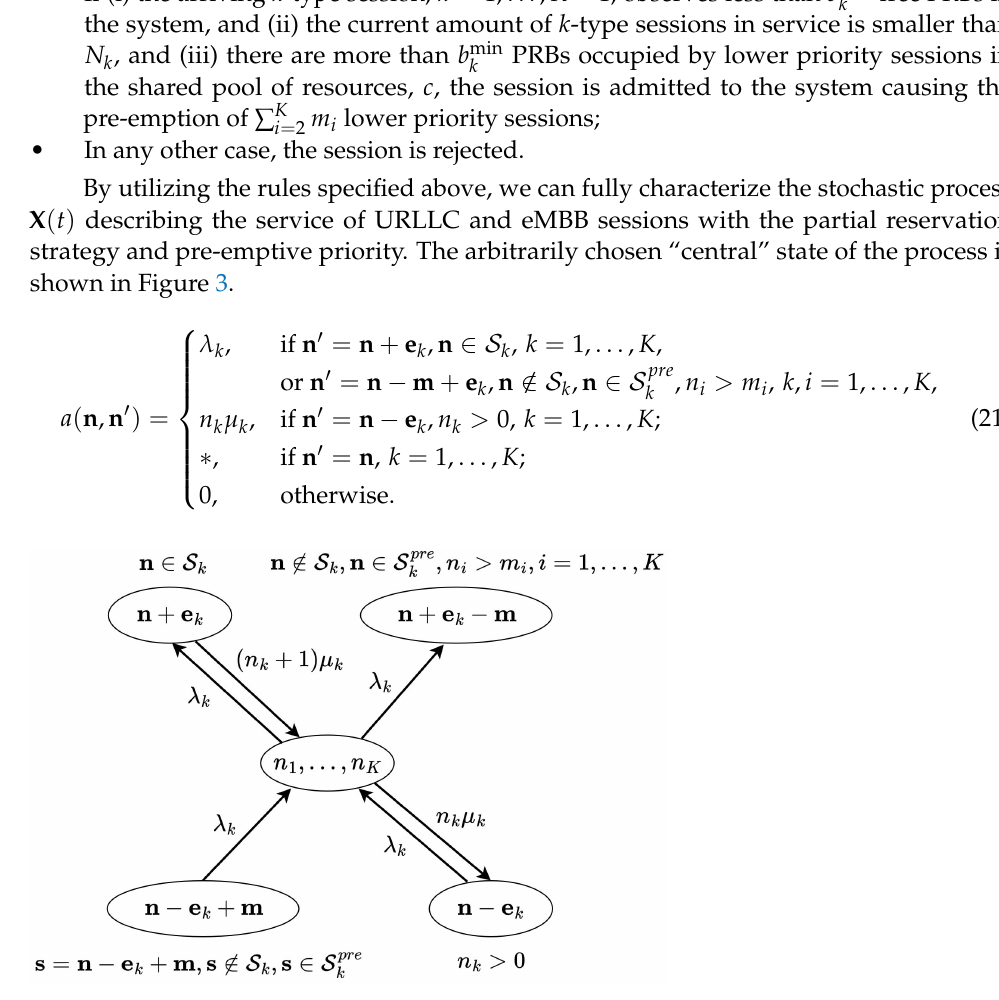
Figure 3. Transition probabilities of the central